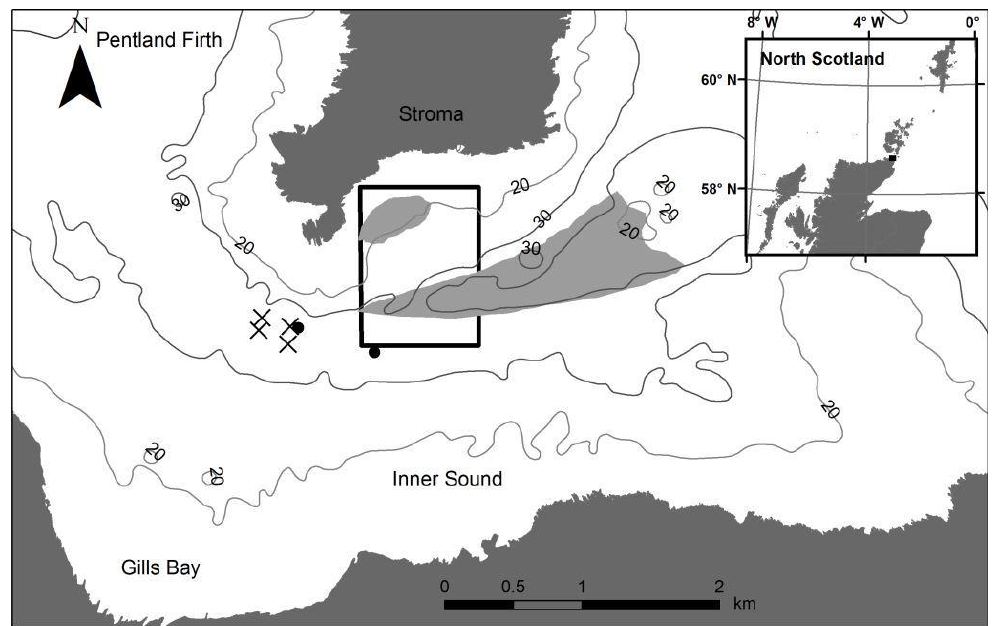
Figure 1. Study site location. The Inner Sound lies between the island of Stroma and Gills Bay on the Scottish mainland. The Pentland Firth lies between the mainland and the Orkney Islands. Also shown; nearshore bathymetry (contours) and the locations of the sediment banks obtained from multi-beam data [3], and ADCP data (●) referred to in Tables 2 and 3 (ADCP 1 is furthest west and ADCP 2 to the east). The positions of the first tidal turbines are noted (x).